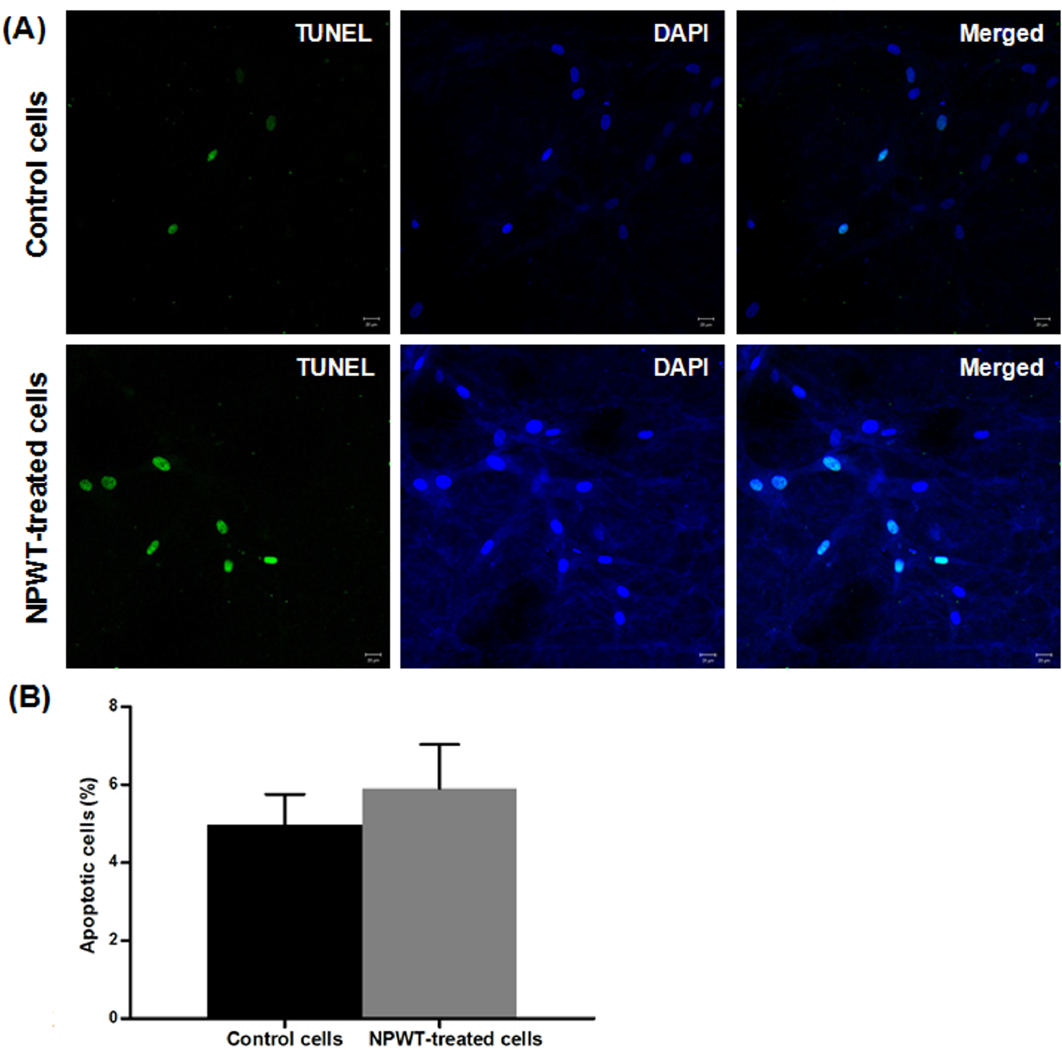
Figure 3. Cell apoptosis assay. Following 72 hours of treatment with suction or static conditions, apoptosis of MSCs was evaluated by TUNEL assay. The images of TUNEL + cells was shown in (A, bars=20 m m). Percentages of apoptotic cells in clots are shown in (B). Compared with control group, 72 hours of suction didn’t result in a significant increase in cell apoptosis ( p . 0.05).